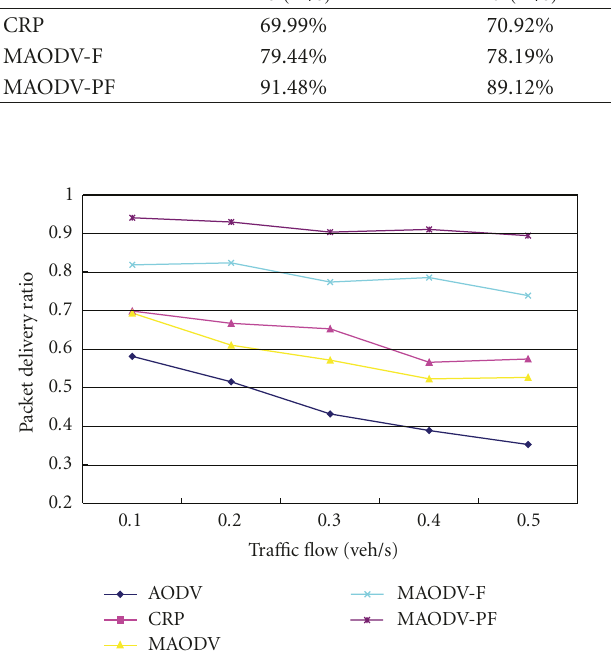
Figure 10: Packet delivery ratios for CRP, AODV, MAODV, MAODV-F, and MAODV-PF under di ff erent tra ffi c flows.